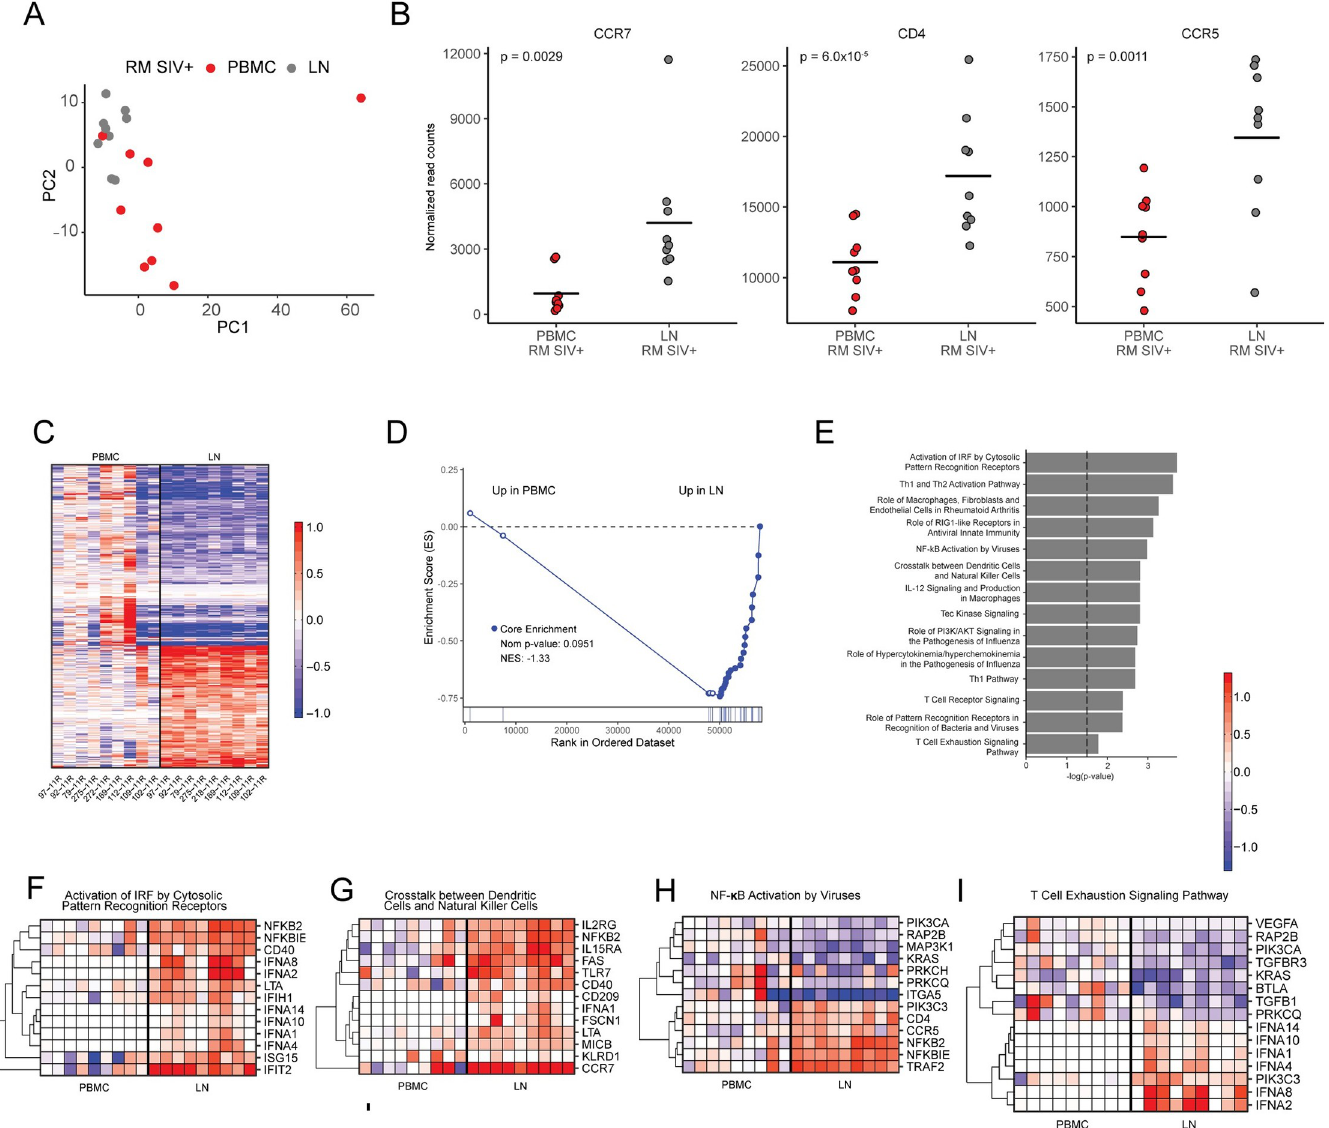
Fig 4. Pathways in innate and adaptive immunity are upregulated in the LNs but not peripheral blood of SIV-infected RMs. (A) Principal component analyses (PCA) of the transcriptomes of peripheral blood (red circles) and lymph node (grey circles) pDCs from SIV-infected RMs. ( B ) Dot plots showing normalized read counts of SIV receptor CD4, co-receptor CCR5 and lymph node homing marker CCR7 transcripts in pDCs from the peripheral blood (red circles) or lymph nodes (grey circles) of SIV-infected RMs. Read counts for individual RMs are shown and the mean is indicated by the black bar. P-values from DESeq2 analysis are shown. ( C ) Heat map of the top DEGs (comparing PBMCs and LNs of SIV-infected RMs) from DESeq2, including genes with FDR < 0.05 and FC > 1.5. Data values were transformed using the “rlog” method from DESeq2 and normalization was done by taking the median across PBMC samples and subtracting this value from all observations. Heat map limits were set to -1 to 1. Animal IDs for the individual RMs are included under the heat map. ( D ) GSEA enrichment plot of the Hallmark interferon alpha response (MSIGDB geneset #M5911) for contrasting expression in the peripheral blood vs lymph nodes of SIV-infected RMs. This plot panel also shows NES and nominal p-values. ( E ) Bar chart of -log p-values from IPA. IPA was used with the same genes as the ones included in panel A (PBMC vs LN, FDR < 0.05, FC > 1.5) as input. Gene sets from IPA were ordered by -log p-value and the top hits as well as hits of interest are included in the plot. ( F )—( J )Breakout gene sets from the IPA shown in panel E. Heat map limits were set at -1.25 to 1.25. Gene set name from the IPA analysis are shown above each plot. In the F - I heatmaps, the order of columns matches that of panel C and the method of transformation and normalization of the data was identical to that described for panel C . elevated ISGs, the expression was significantly higher in cells derived from LNs. To fully char- acterize this activation phenotype of LN pDCs, we conducted pathway analysis of genes differ- entially expressed between pDCs from LN vs blood ( Fig 4D-4J ). Several pathways such as